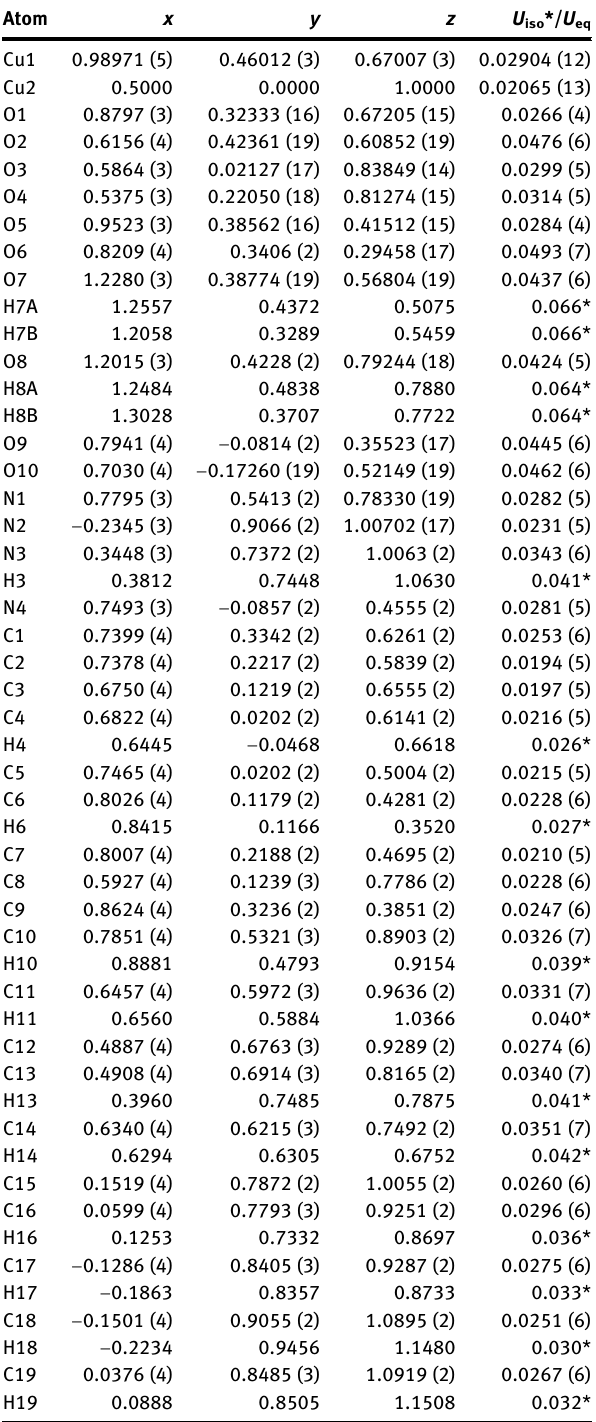
Table  : Fractional atomic coordinates and isotropic or equivalent isotropic displacement parameters (Å 